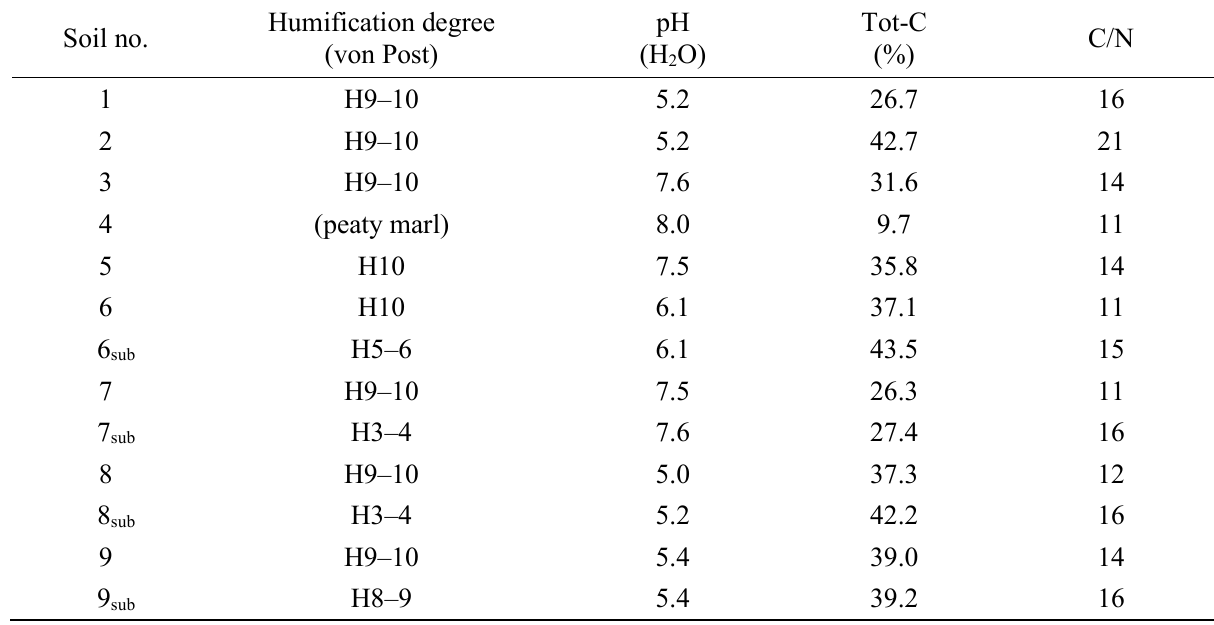
Table 2. Humification degree, pH, total carbon content (Tot-C) and carbon/nitrogen quotient (C/N) of the 13 topsoil and subsoil samples taken at nine sampling sites in